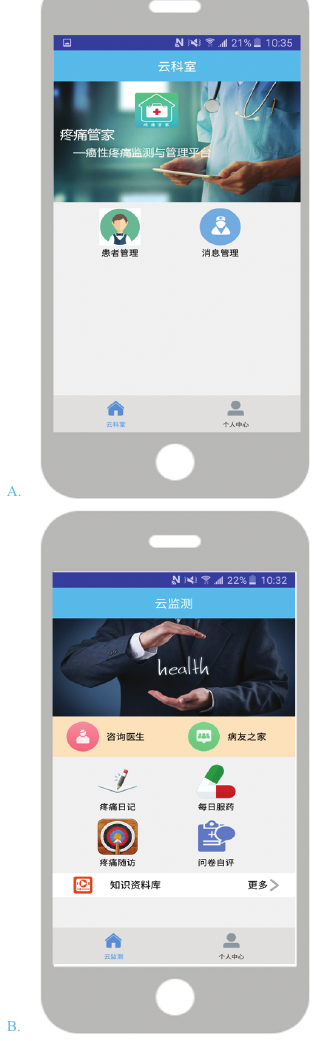
Figure 3. Screenshots of the home page: (A) the home page of patient client and (B) the home page of medical client.